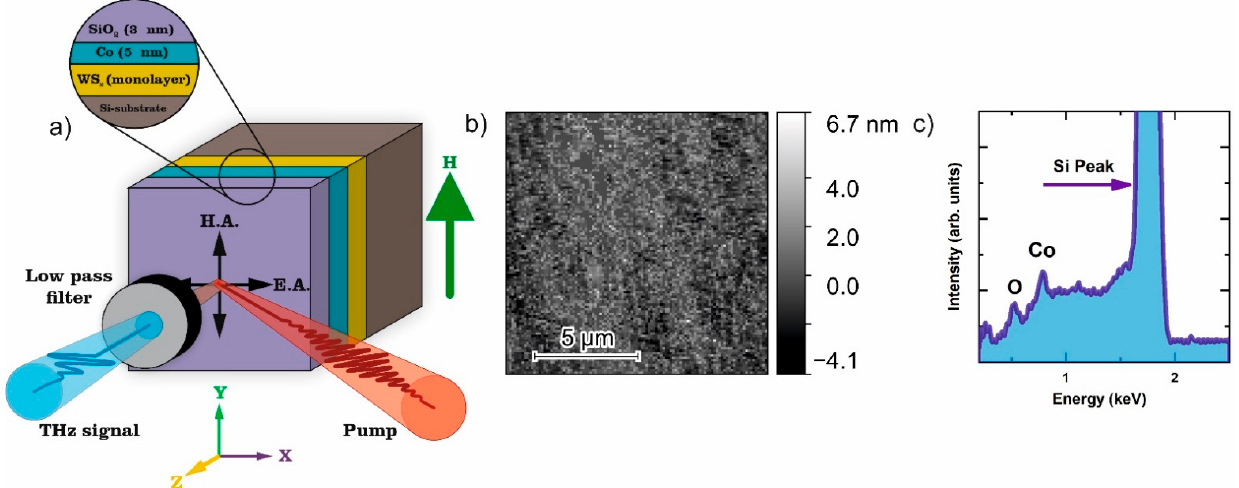
Figure 1. ( a ) Schematic structure of the sample and experimental configuration. ( b ) AFM image of sample surface with a pseudo color scale. ( c ) EDX spectrum characteristic of the sample with 3 peaks correspondent to Co, O, Si. Accelerating voltage is 12 kV.